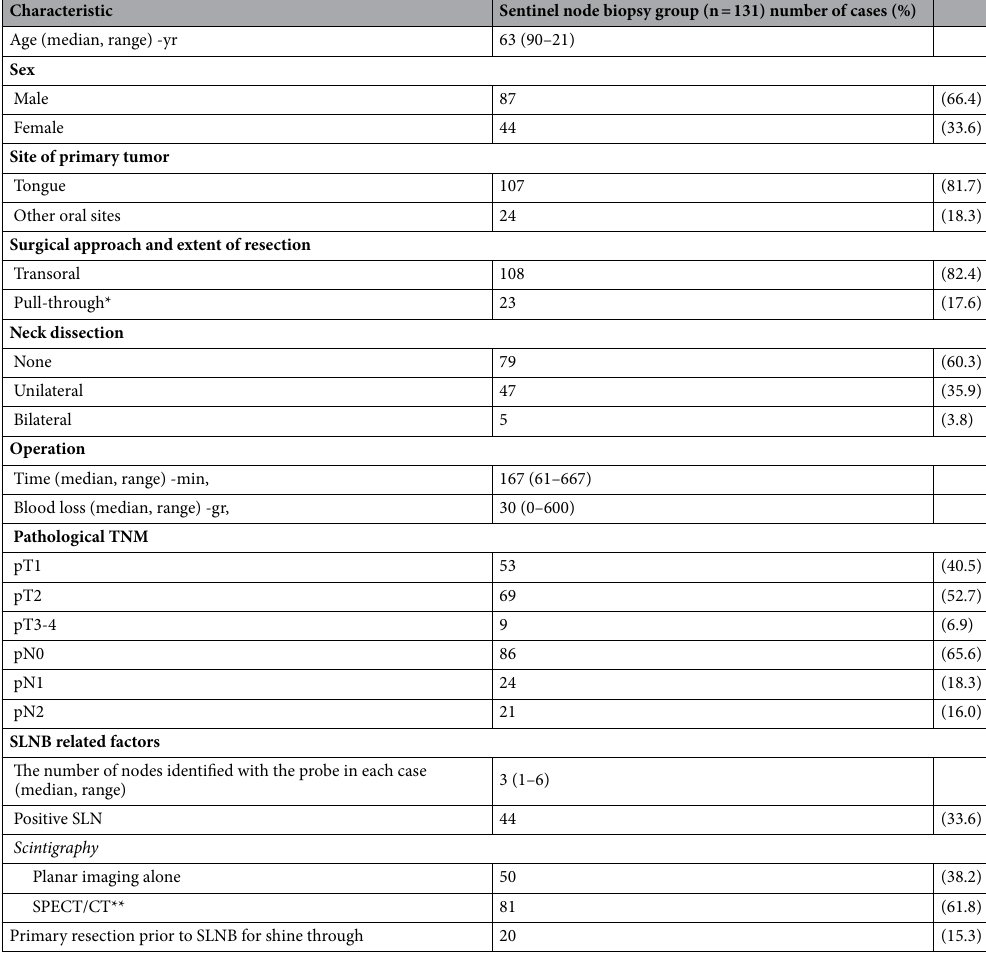
Table 1. Characteristics of the patients at baseline. *Pull-through: en bloc resection of the primary and neck tissues. **SPECT/CT: single-photon emission computed tomography/computed tomography, the fusion of functional images by SPECT and anatomical images by CT. SLN: sentinel lymph node; SLNB: sentinel lymph node biopsy; TNM: tumor, node,